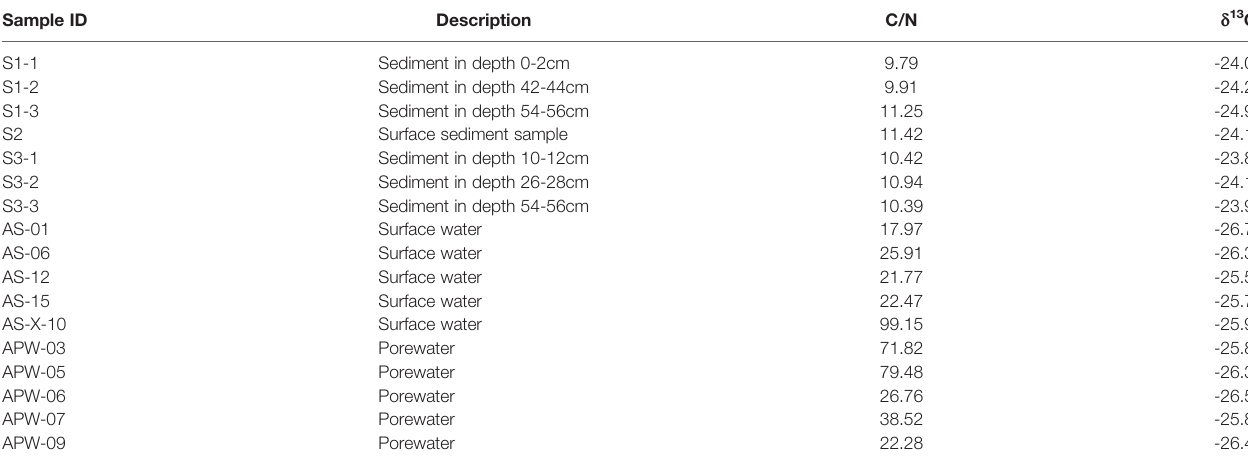
TABLE 4 | C/N molar ratio and d 13 C value in sediment, surface water and porewater samples. Sample ID